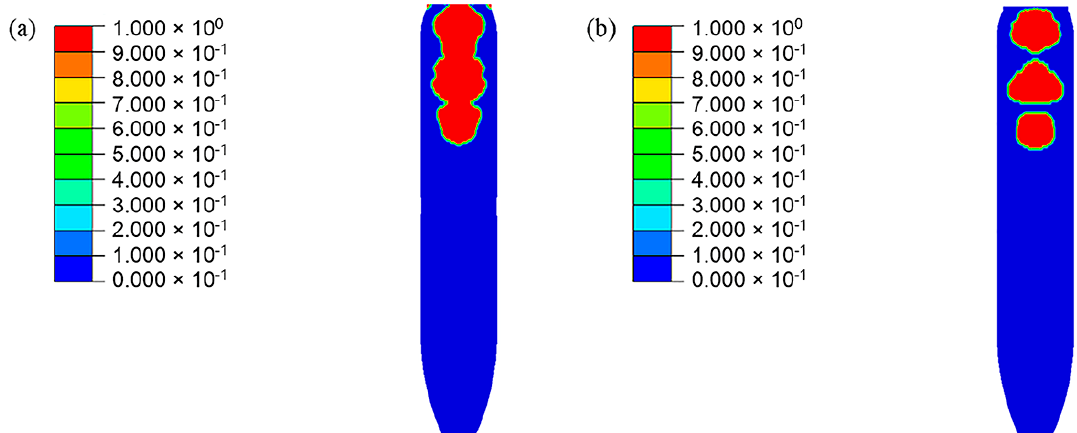
Figure 21. Damage distribution in PBX1314. ( a ) No friction between the projectile and PBX1314 (It